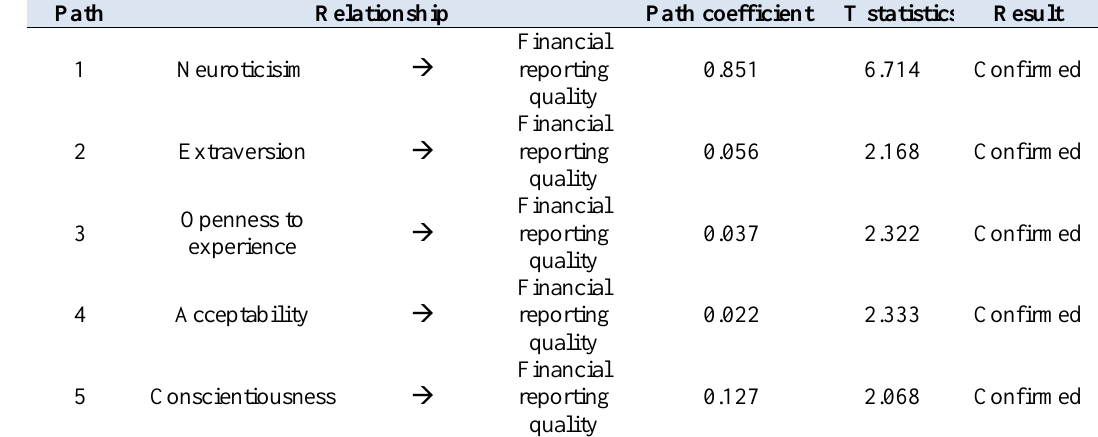
Table 5. Path coefficient values and t-statistic of hypotheses related to research model paths